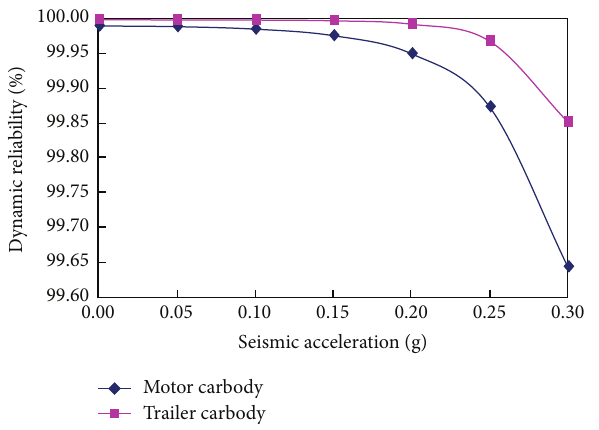
Figure 18: Dynamic reliability for wheel load decrement ratio with respect to seismic acceleration.